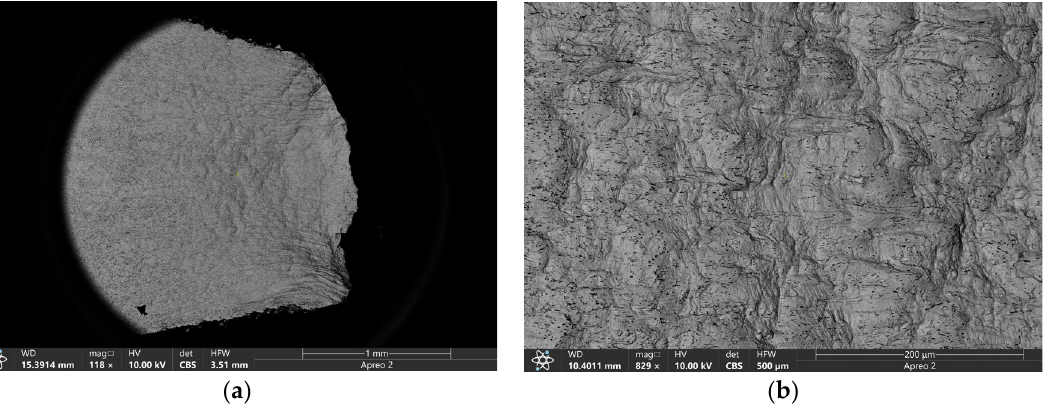
Figure 20. SEM BSE images of the “copper − steel” sample after tensile testing in the neck area: ( a ) general view of the destroyed part of the sample; ( b ) image of the forming block structure.